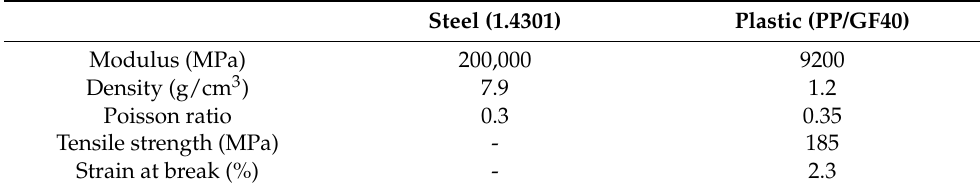
Table 4. Material properties of the metal and plastic